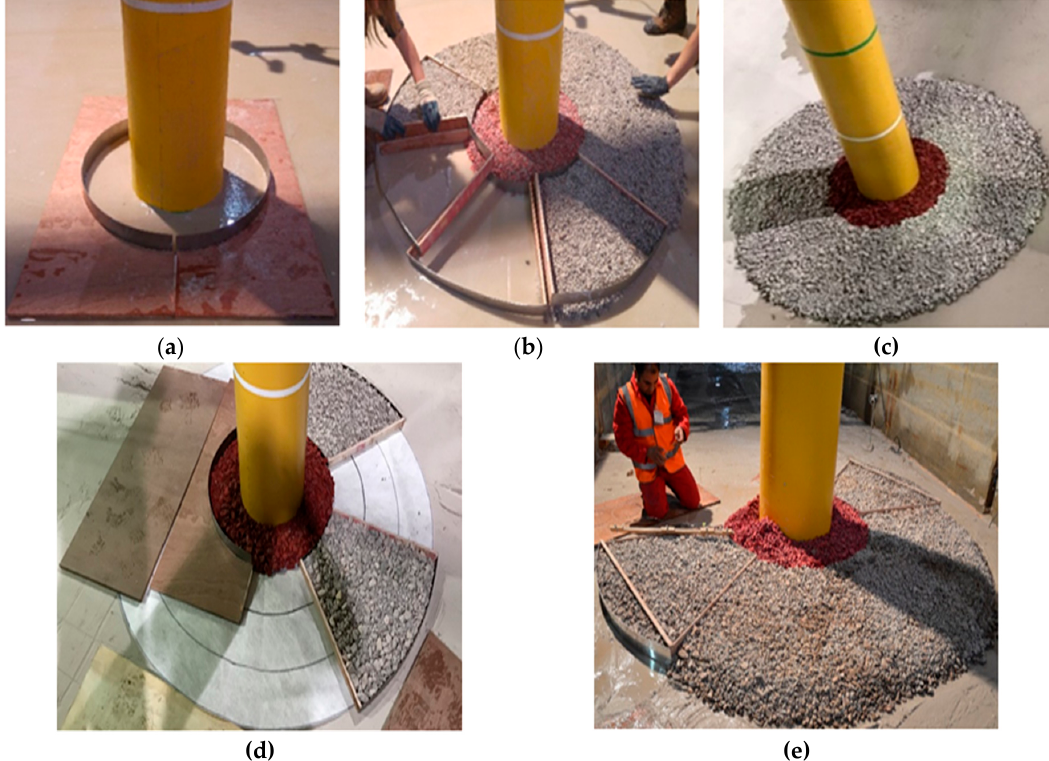
Figure 4. Installation of a scour protection scale model scale (scale 1:16.7). ( a ) Inner ring templates placed around the monopile; ( b ) outer ring placement using templates; ( c ) finalized scour protection model; ( d ) scour protection model placement over a geotextile; ( e ) placement of a scale model (scale 1:8.3) using larger templates.